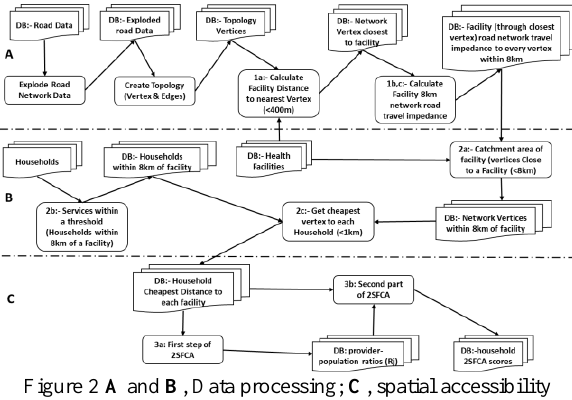
Figure 2 A and B , Data processing; C , spatial accessibility